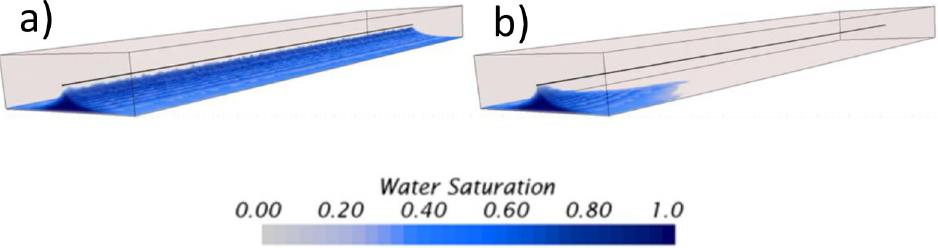
Fig 6. Dynamics of the water movement near the wellbore for the permeability sensitivity analysis, a) at k = 0.01 d , b) at k = 100 d . 3D renders taken at the breakthrough time.